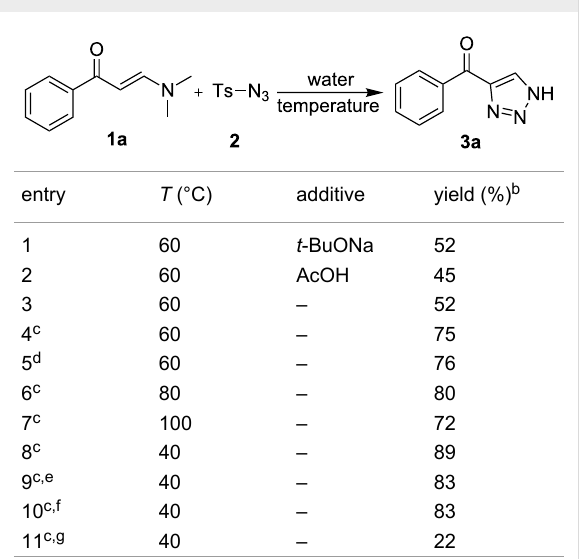
Table 1: Screen and optimization of the reaction conditions.